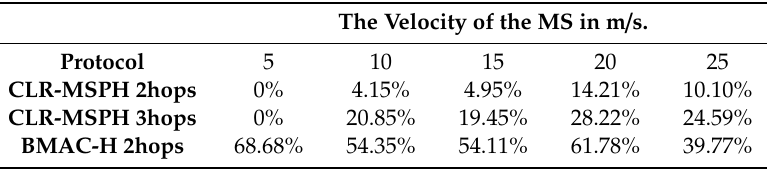
Table 3. Handover packets in each protocol varying the speed of MS. The Velocity of the MS in m / s.